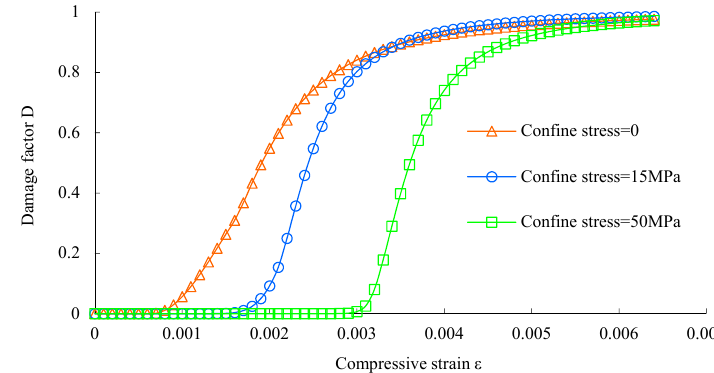
Figure 3. Damage factor of concrete under compression.